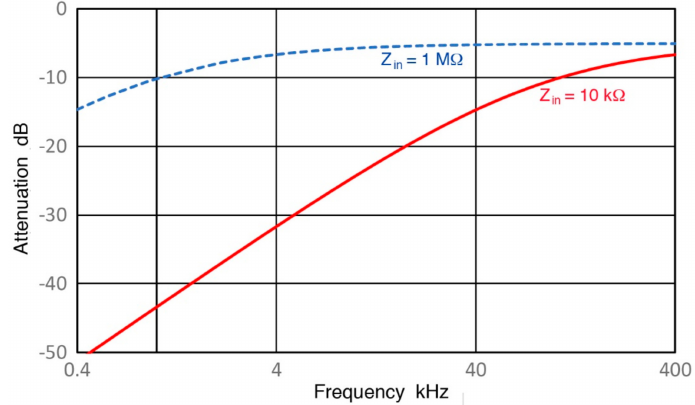
Figure 7. Attenuation caused by increasing sensor impedance with decreasing test